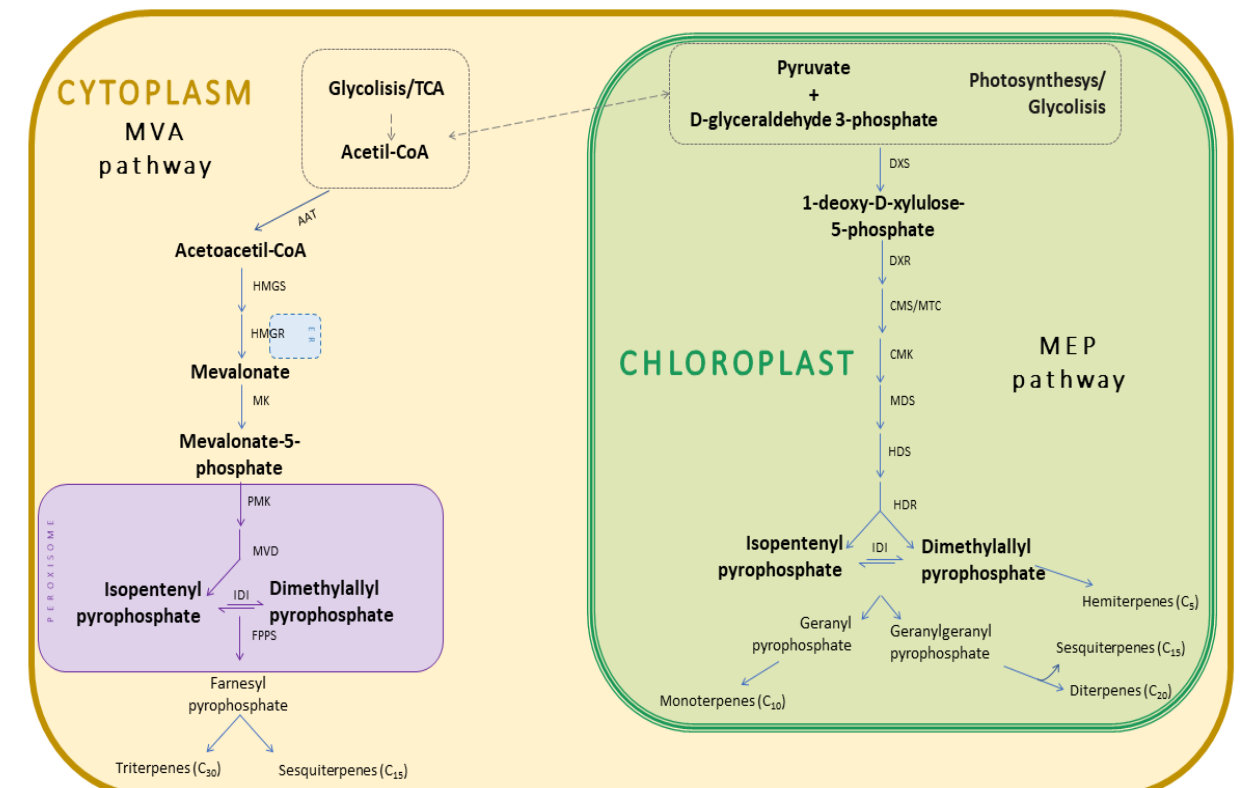
Figure 1. Terpenes and terpenoids are the most common constituents of EOs. The biosynthesis of these compounds in plants occurs via two main pathways: the mevalonate (MVA) pathway in the cytosol and the methylerythritol phosphate (MEP) pathway in the plastids. Both pathways produce the C 5 precursors isopentenyl pyrophosphate (IPP) and dimethylallyl pyrophosphate (DMAPP), which are condensed via geranyl/farnesyl pyrophosphate synthase to give the C 10 (geranyl diphosphate, GPP), C 15 (farnesyl diphosphate, FPP), and C 20 (geranylgeranyl pyrophosphate) precursors for isoprenoid production. Depending on the number of carbons, isoprenoids are grouped in monoterpenes (C 10 ), sesquiterpenes (C 15 ), diterpenes (C 20 ), triterpenes (C 30 ), etc., with the first two groups being the main constituents of EOs. Monoterpenes and diterpenes tend to be formed in the plastids, where unique cyclases produce the ring structures. Aromatic compounds, including phenylpropanoids, are less common and are derived mainly from the shikimate pathway, but a few phenols, such as carvacrol and cuminaldehyde, are derived from terpene biosynthesis by desaturation. The graphical representation of MVA and MEP pathways are adapted and re-drawn from Vickers et al. [27]. MVA pathway enzymes abbreviations: AAT , acetyl-CoA C-acetyltransferase; HMGS , hydroxymethylglutaryl-CoA synthase; HMGR , hydroxymethylglutaryl-CoA reductase; MK , mevalonate kinase; PMK , phosphomevalonate kinase; MVD , diphosphomevalonate decarboxylase; IDI , isopentenyl diphosphate isomerase; FPPS , farnesyl pyrophosphate synthase. MEP pathway enzymes abbreviations: DXS , deoxyxylulosephosphate synthase; DXR , deoxyxylulosephosphate reductoisomerase; CMS , diphosphocytidylmethylerythriol synthase; CMK , diphosphocytidylmethylerythriol kinase; MDS , methylerythriol cyclodiphosphate synthase; HDS , hydroxymethylbutenyl diphosphate synthase; HDR hydroxymethylbutenyl diphosphate reductase; IDI , isopentenyl diphosphate isomerase.